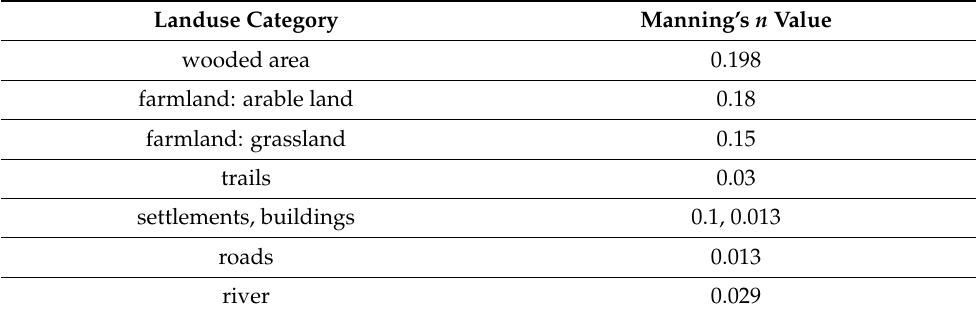
Table 6. Initially assigned Manning’s n value [65–67].